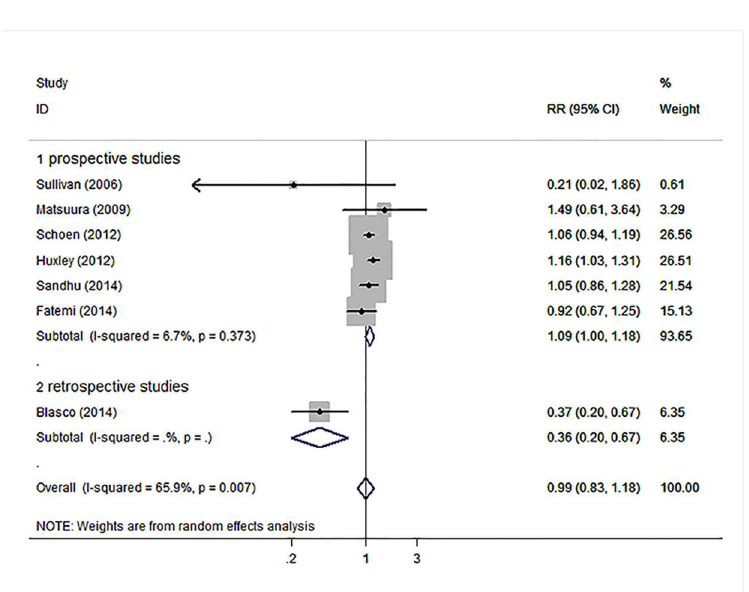
Fig 3. Forest plot demonstrating the association between HbA1c levels and AF depending on different study styles which HbA1c levels were analyzed as categorical variable. Relativerisks of AF for higherHbA1c comparedwith lower HbA1c. Squares indicatestudy-specific risk estimates (size of the square reflects the study-specific statistical weight, that is, the inverseof the variance); horizontallines indicate 95% CIs; diamondindicatessummary risk estimate with its corresponding 95%